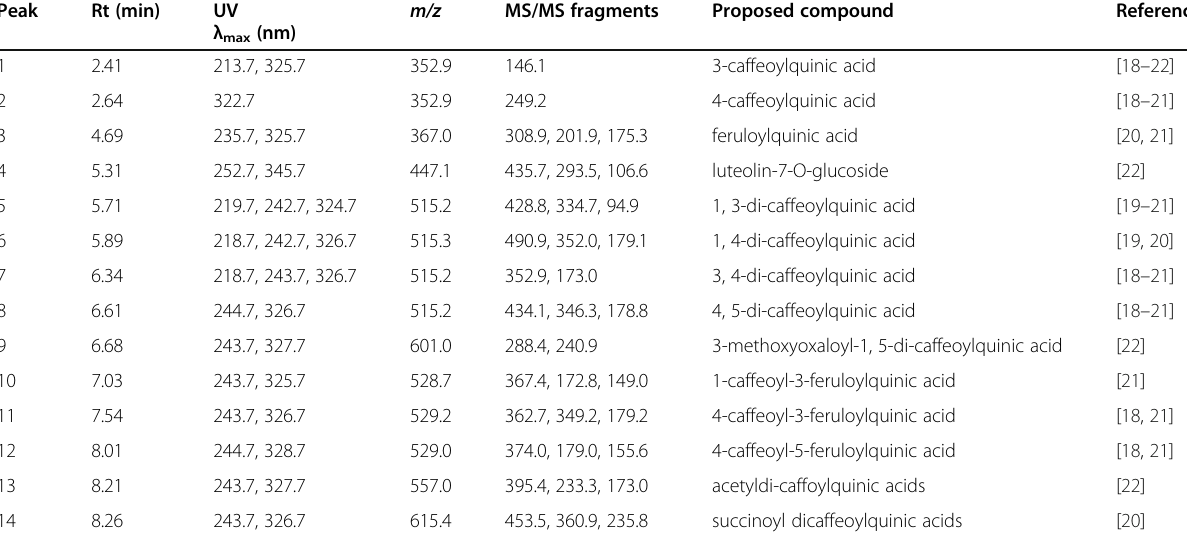
Table 1 Proposed compounds detected in G. pensylvanicum obtained by UPLC-ESI- MS/MS Peak Rt (min) Proposed compound